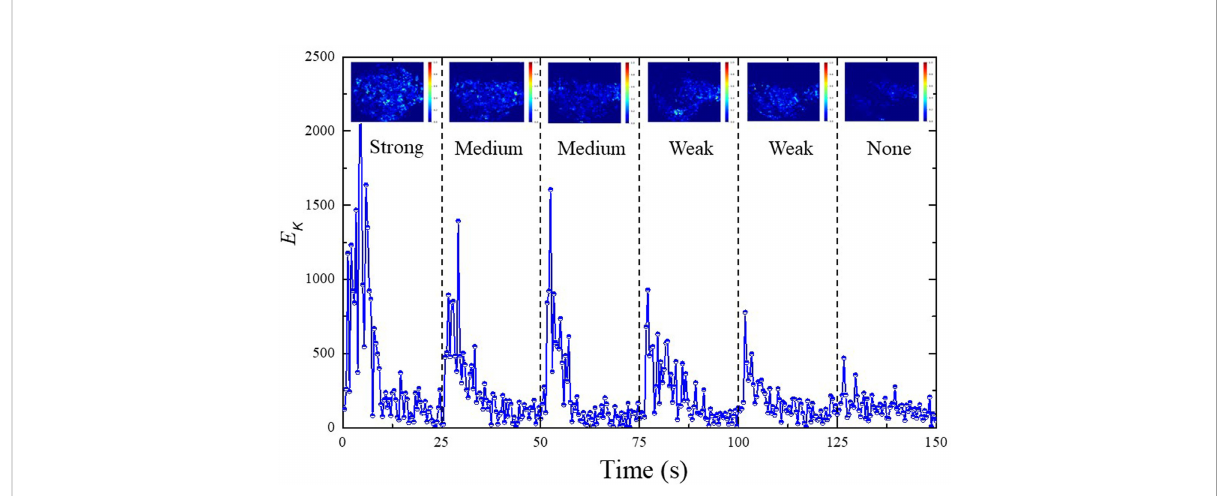
FIGURE 2 Diagram of the modi fi ed kinetic energy over time within a single round feeding event (None: fi sh do not respond to food; Weak: fi sh eat only pellets that fall directly in front of them but do not move to take food; Medium: fi sh move to take food, but return to their original positions; Strong: fi sh move freely between food items and consume all the available food. Noted that, the heat maps generated by the optical fl ow of the points with the maximum kinetic energy are used to better visualized fi sh appetite